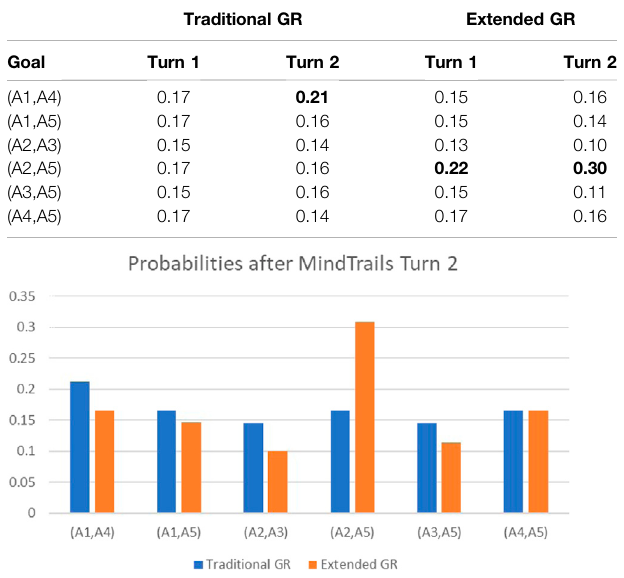
TABLE 1 | A representative calculation to illustrate the differences between traditional and extended GR. (Figures in bold indicate the goals with the highest probability. Under traditional GR, there is no clear winner after Turn 1).